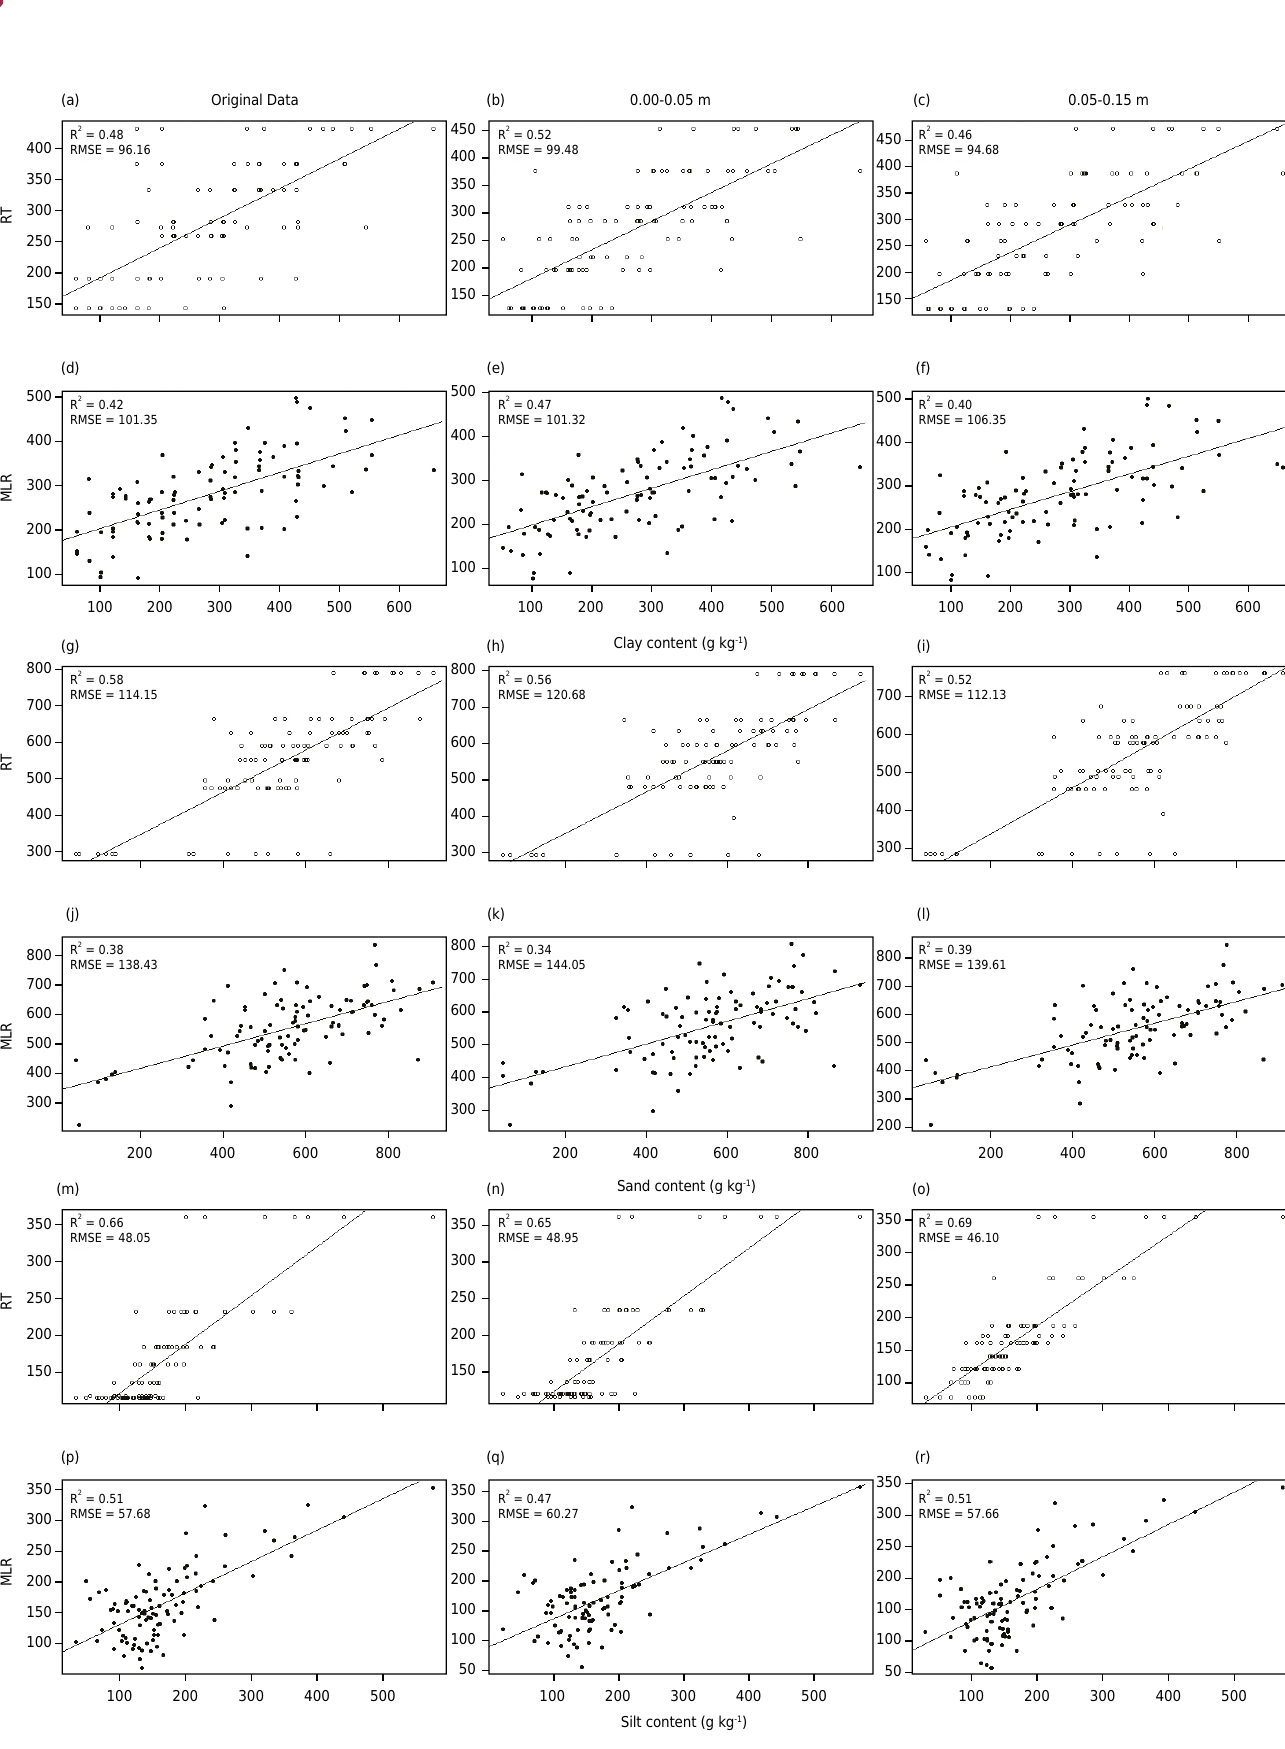
Figure 3. Plotted results of clay, sand, and silt content predictions for the three input datasets (original data, and harmonized layers of 0.00-0.05 and 0.05-0.15 m). RT = Regression Tree; MLR = Multiple Linear Regression; RMSE = Root Mean Square Error; Y axis = predicted values; X axis = observed